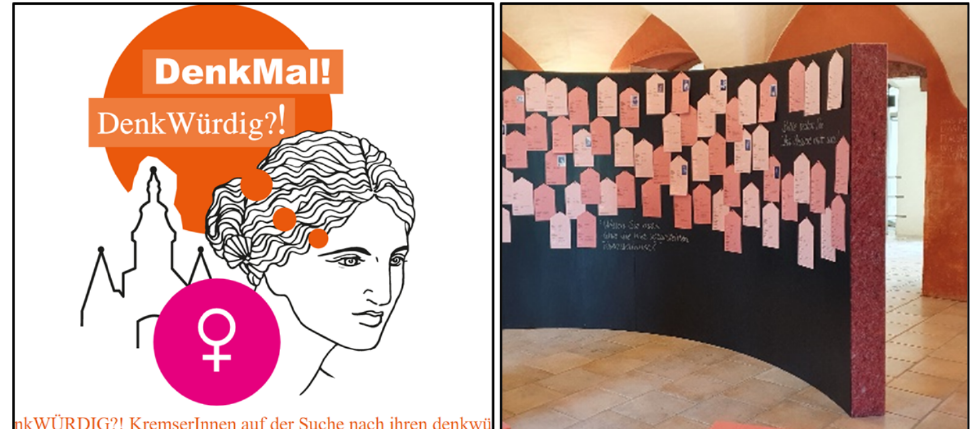
Figure 2. Web-project ( left ) and exhibition ( right ) on unknown and forgotten women in